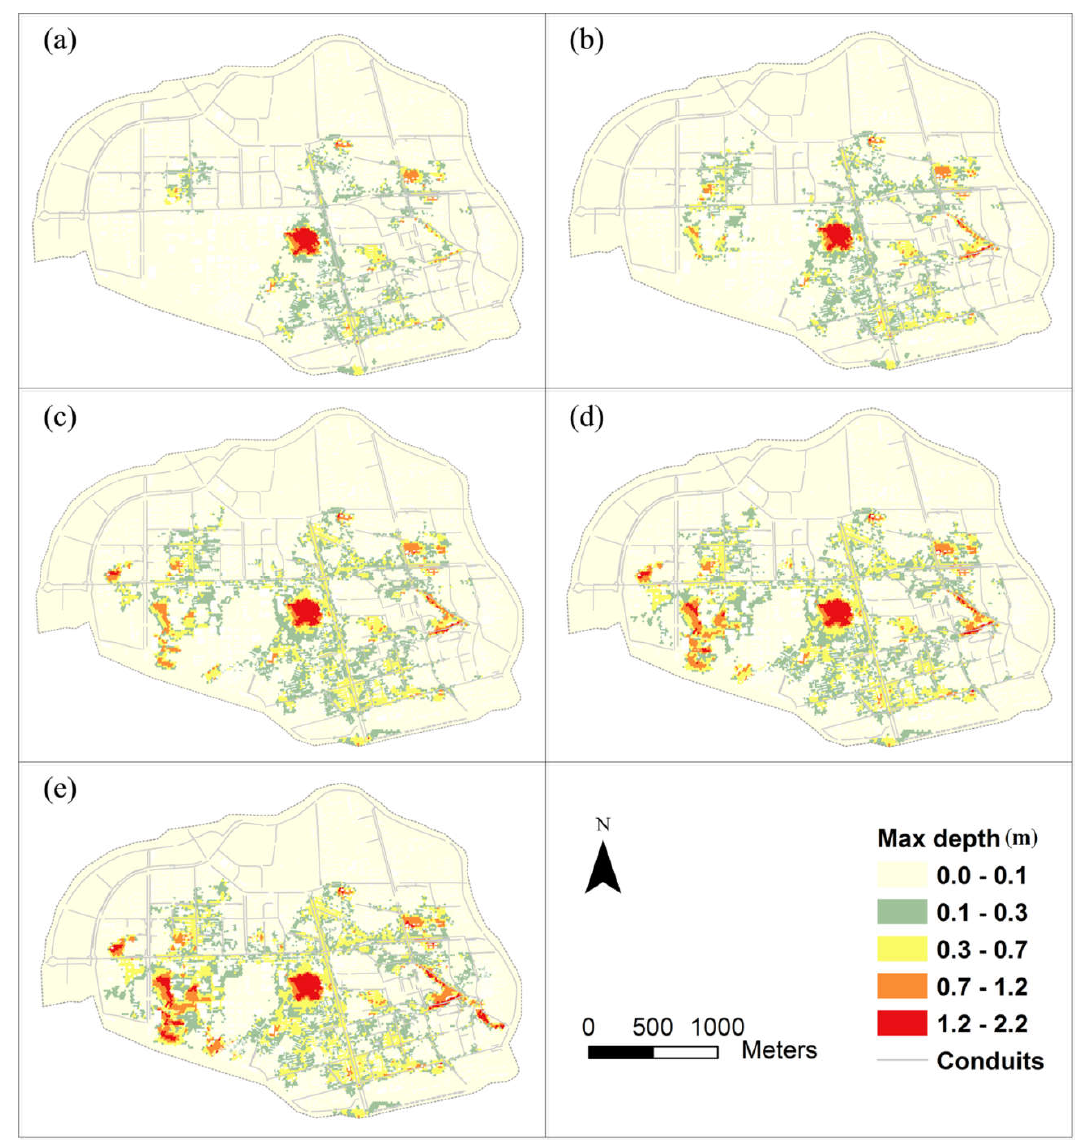
Figure 11. Maximum inundation depths in different RPs of rainfall and storm surges: ( a ) 5-year RP, ( b ) 10-year RP, ( c ) 20-year RP, ( d ) 50-year RP, ( e ) 100-year